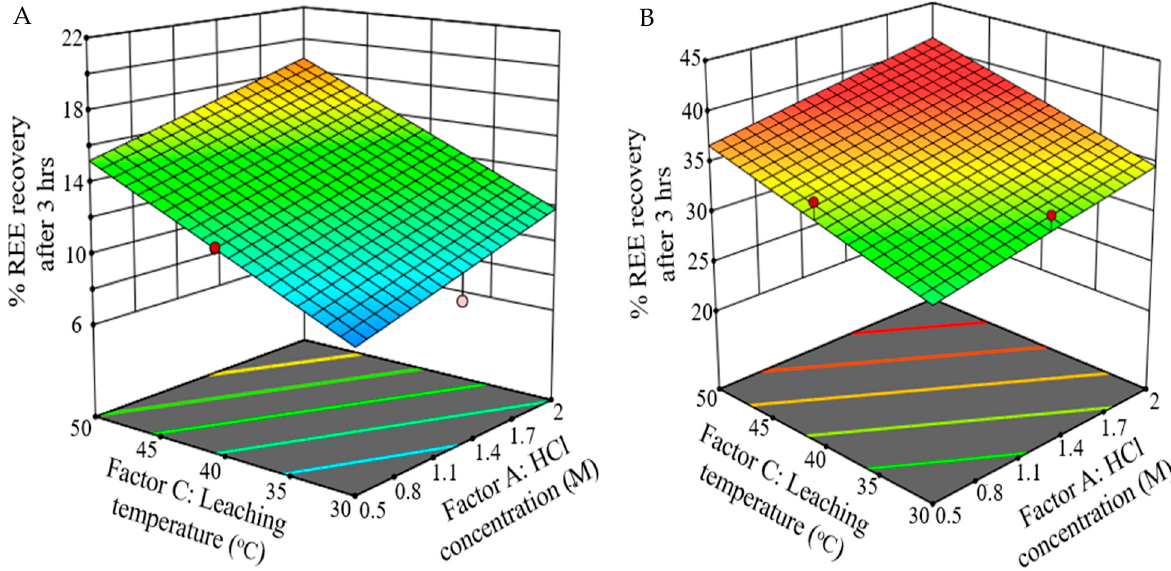
Figure 2. 3D surface plots of the relationship between temperature, HCl concentration, and their impact on the % REE leaching recovery for RC1 ( A ) and DC1 ( B ).